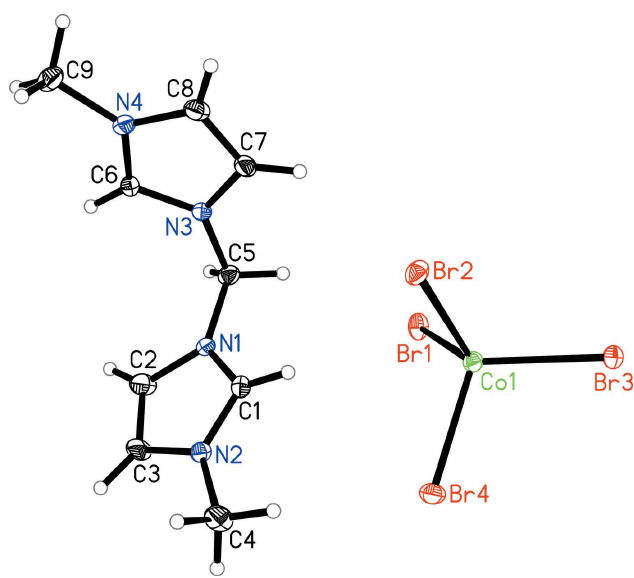
Figure 1 Molecular structure of the title compound with atom labelling and displacement ellipsoids drawn at 30% probability